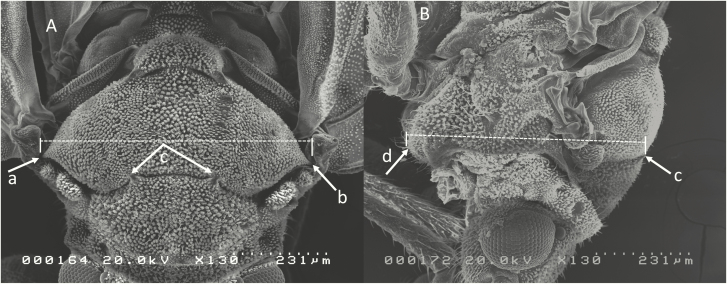
SEM image of external morphology of Diaphorina citri showing the measurement of width (A) and height (B). Outermost arrows (2Aa and 2Ab) are the morphological features defining width. The arrows marked ‘c’ in (A) indicate the same morphological feature as arrow ‘c’ in (B). Arrow ‘d’ is determined by the curvature of the sclerite. Measurements were used as an estimate of size in determining the insect’s ability to pass through screens of different hole sizes.